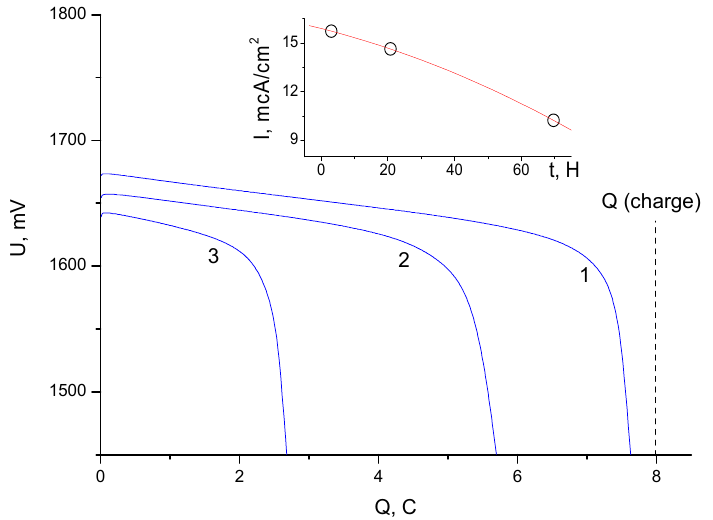
Figure 7. Discharge galvanostatic curves (with a current of 5 mA) obtained after charging cell 3 by 8 C for different exposure times after charging: 1—exposure for 2.5 h; 2—exposure for 21 h; 3—exposure for 69 h. The inset shows the dependence of the specific leakage current on the exposure time.